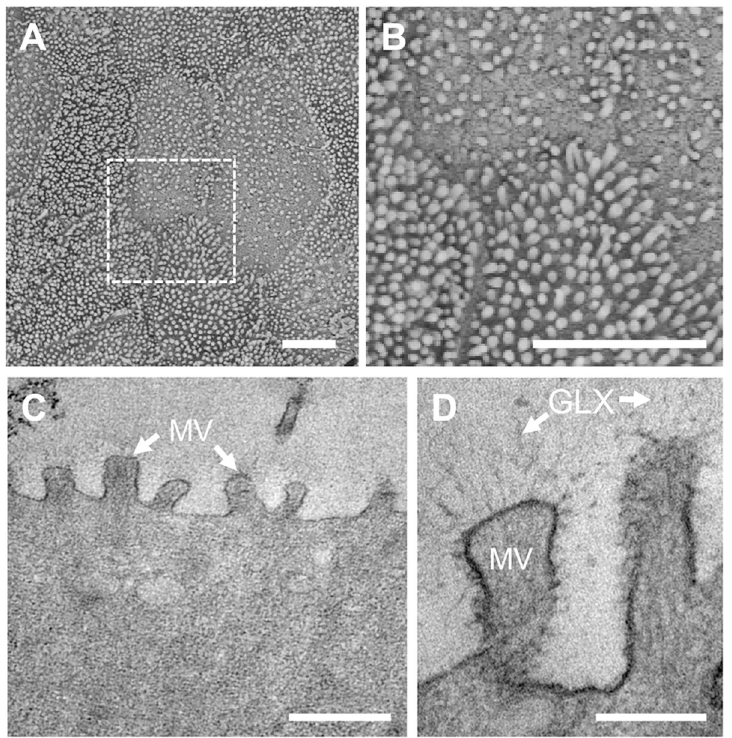
Fig 2. Electron microscopic characterization of the apical surface and the tissue interface of the canine colonoid- derived monolayer. ( A ) A low magnification SEM image of the microvilli on the apical cell surface. ( B ) A high-power magnification of the microvilli from A indicated by a white dashed box. Bars, 5 μ m. ( C ) A TEM image of the microvilli on the cell monolayer. MV, microvilli. Bar, 500 nm. ( D ) A high-power TEM image that shows the microvilli (MV) and the surrounding glycocalyx (GLX). Bar, 200